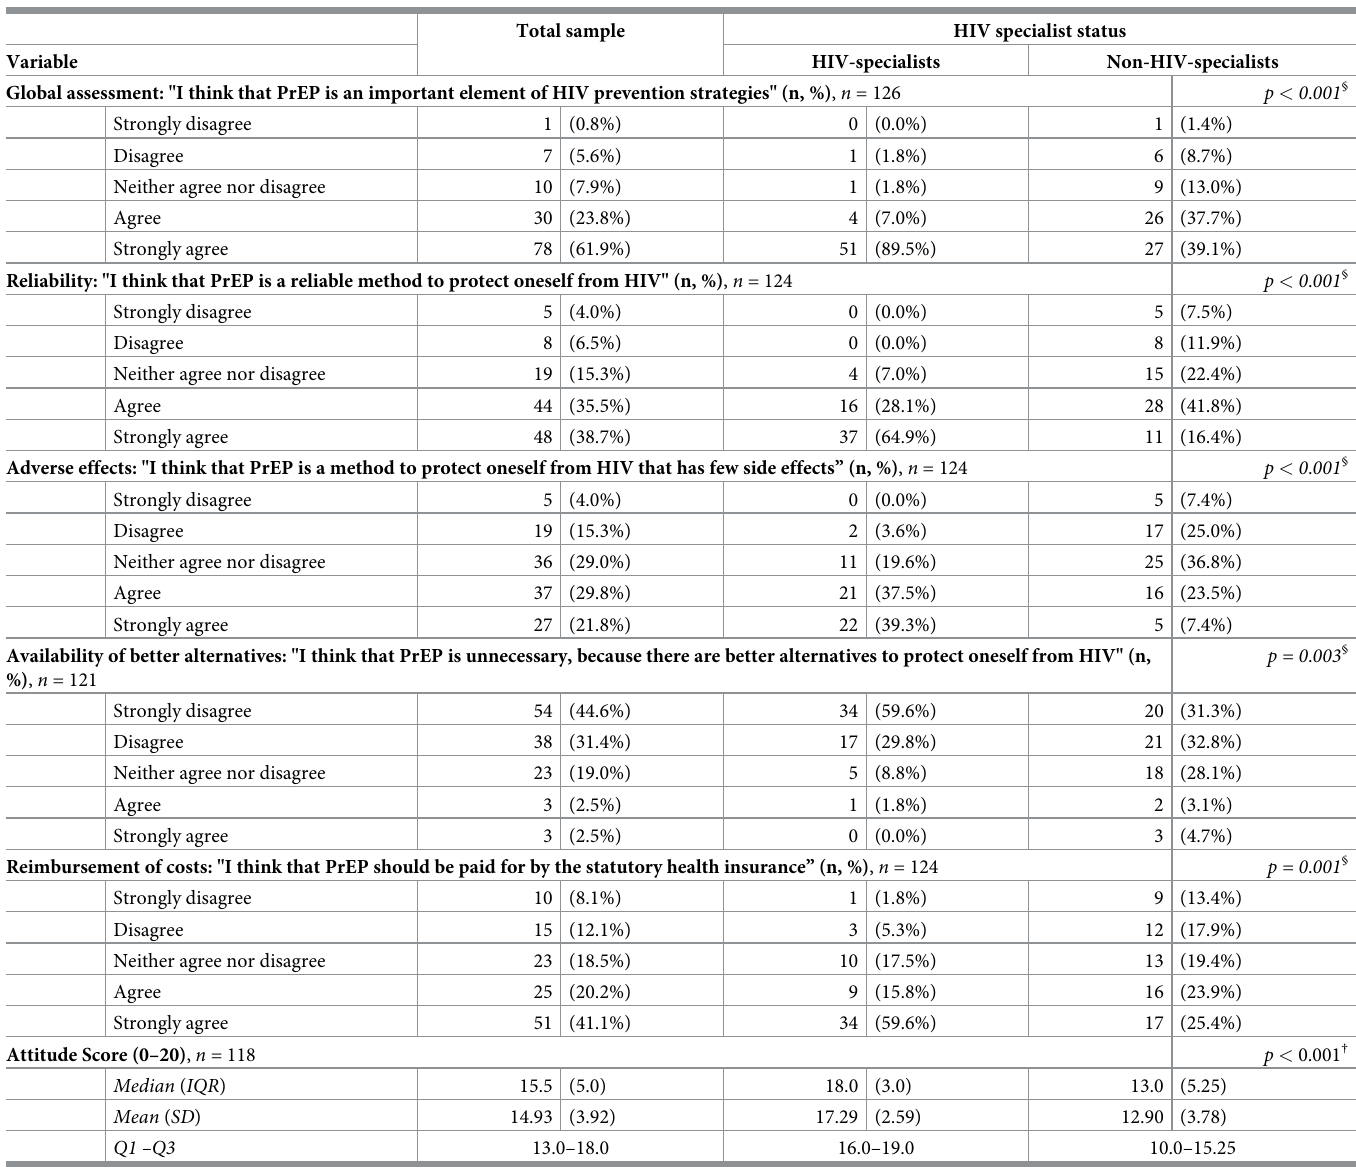
Table 5. Attitudes towards PrEP. Total sample HIV specialist status Variable HIV-specialists